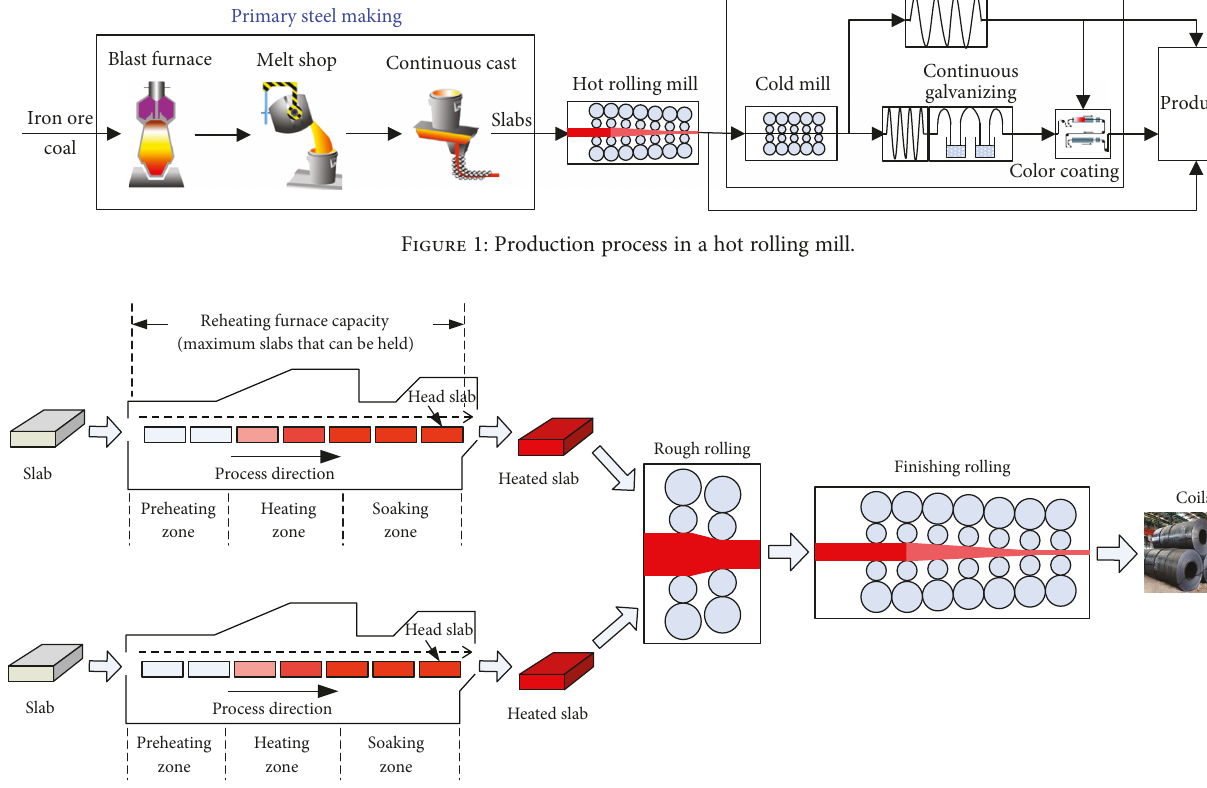
Figure 2: Production process in a hot rolling